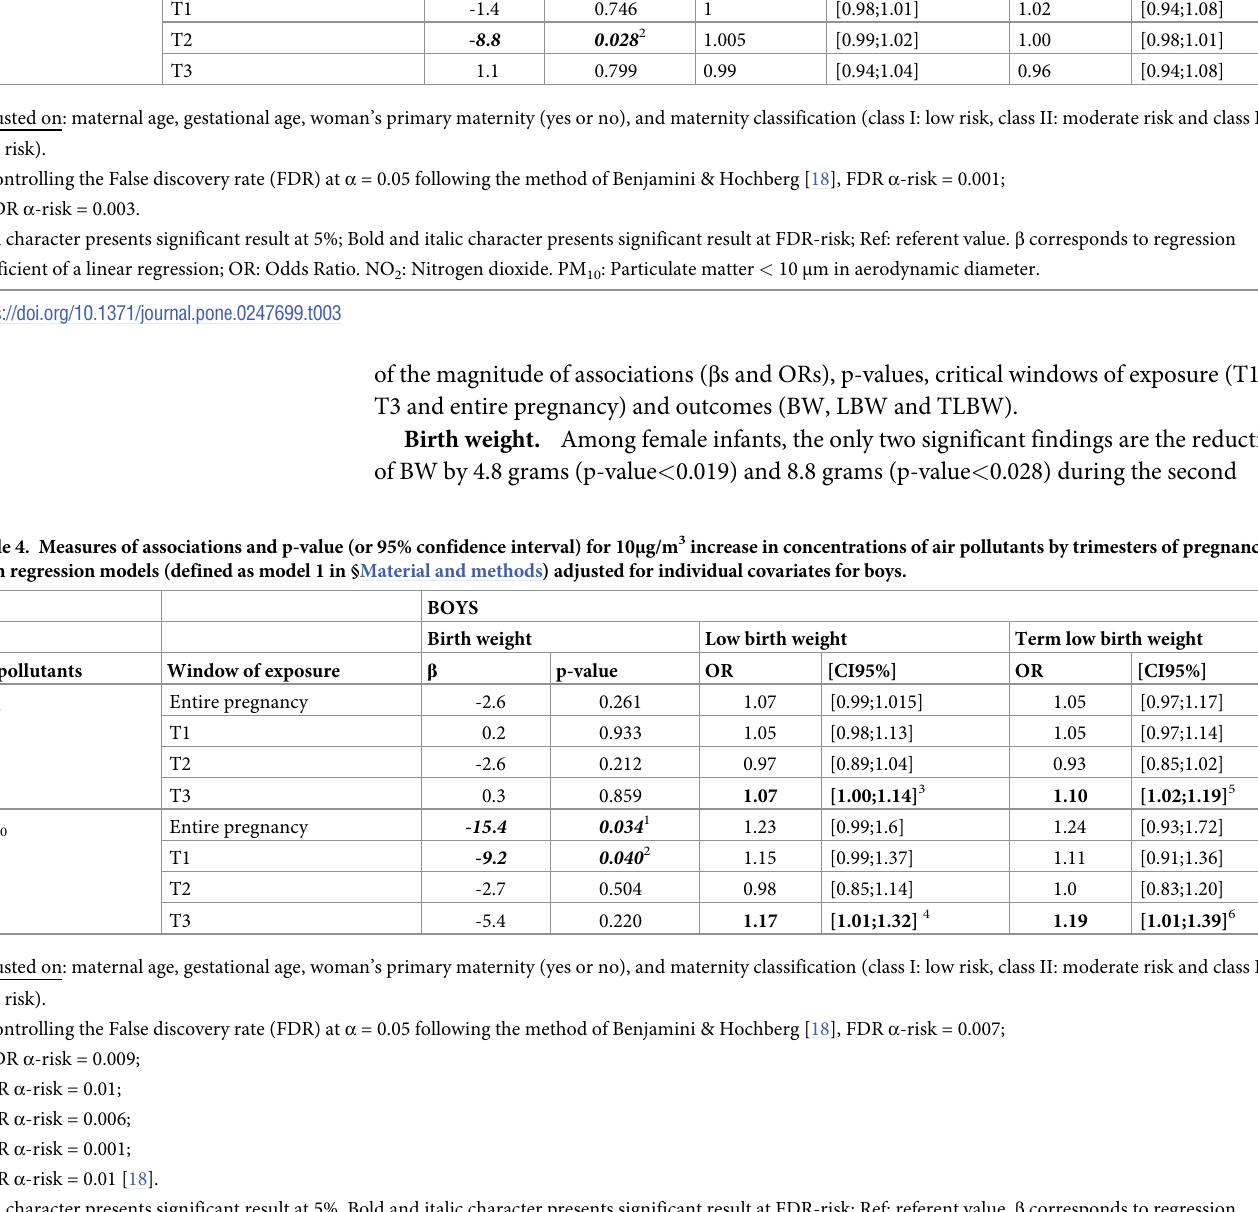
PM 10 Entire pregnancy